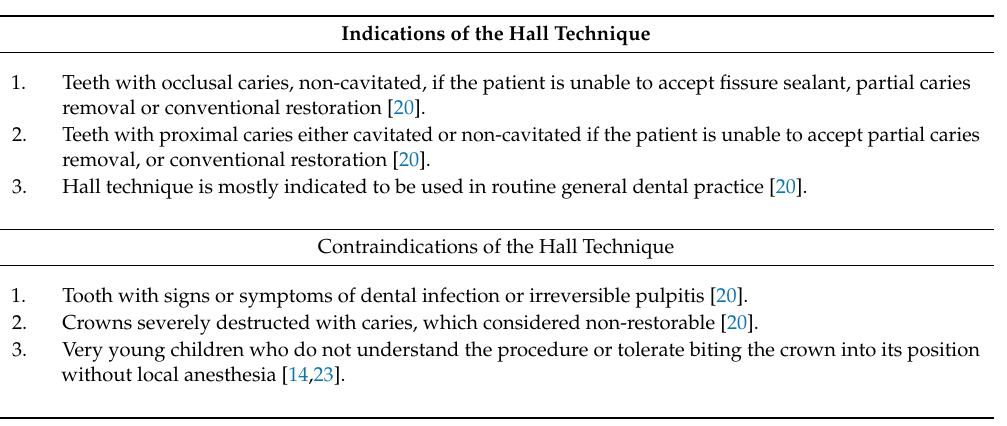
Table 1. Hall technique indications and contraindications for carious primary